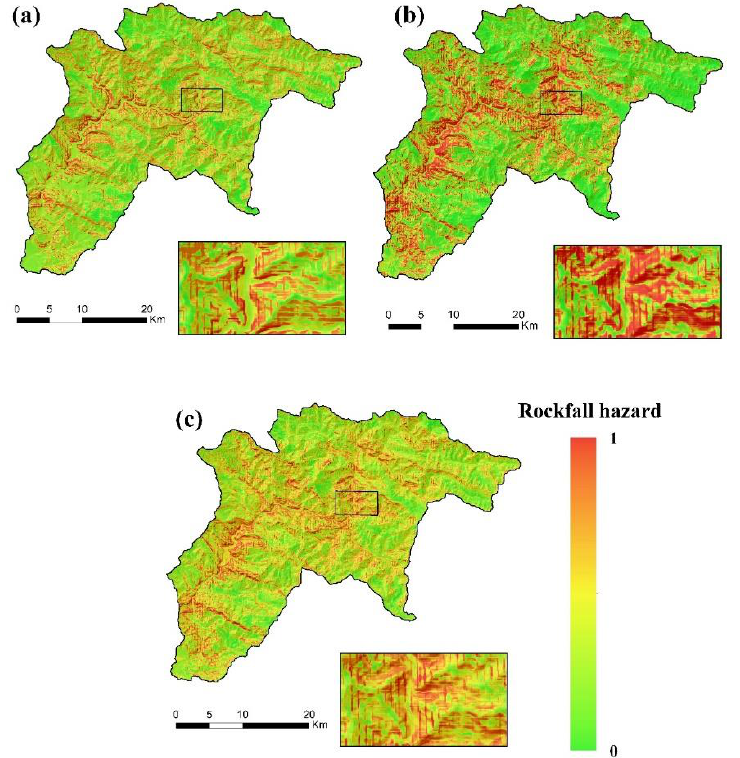
Figure 5. Rock-fall hazard maps using: ( a ) BRT, ( b ) GAM, and ( c ) SVM.